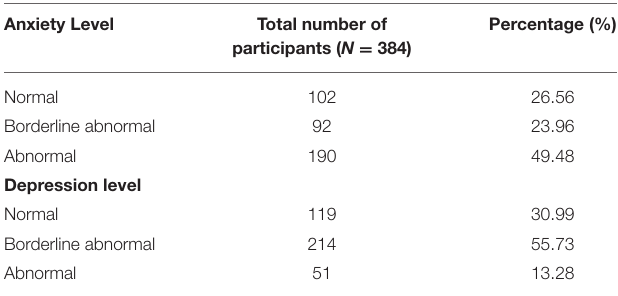
TABLE 3 | Proportion of heart patients with depression and anxiety levels patients among hospitalized, ( N = 384). Anxiety